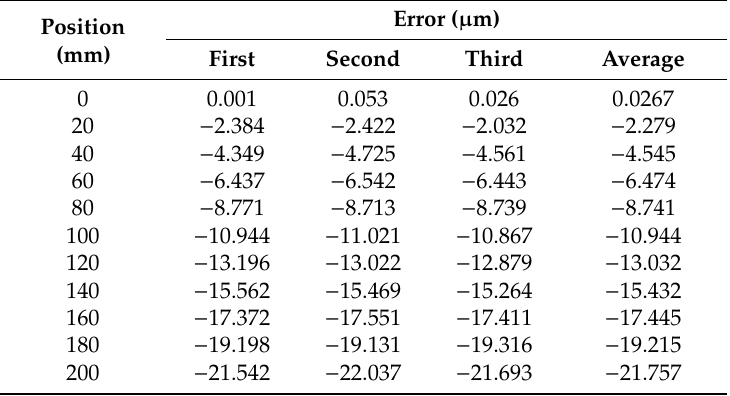
Table 9. Position error in the Z direction.